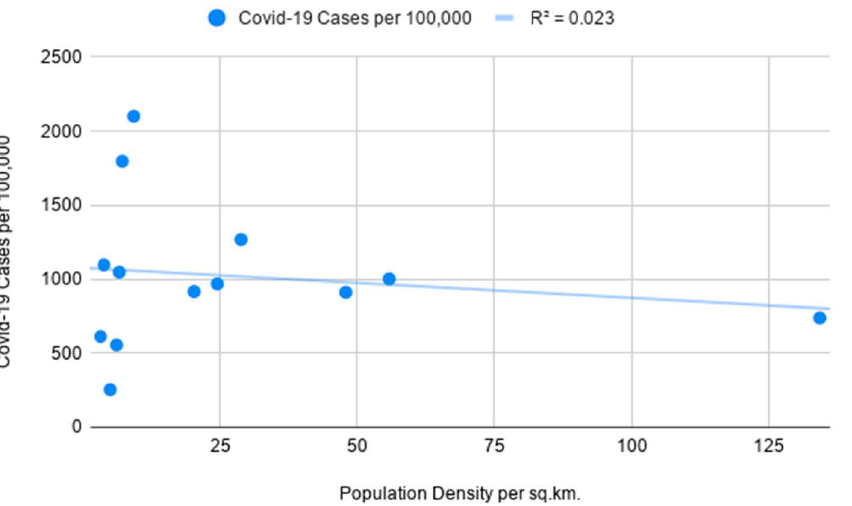
Figure 5. Simple linear regression with population density as an independent variable and Covid-19 cases as a dependent variable for Saudi Arabia’s administrative divisions.